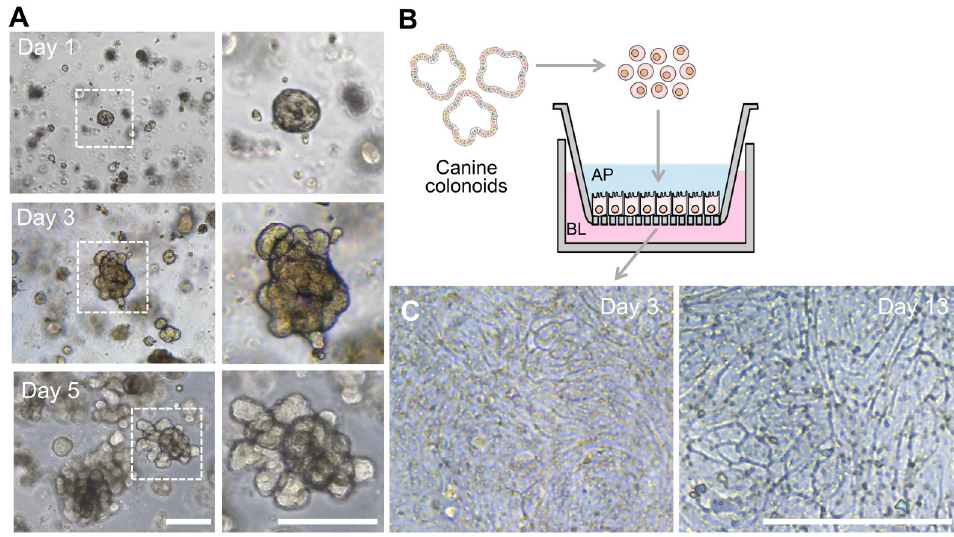
Fig 1. Morphological analysis of the 3D colonoids and the 2D canine colonic monolayer. ( A ) A growth profile of the colonoid isolated from the canine colonic crypt. A small spherical colonoids progressively grows to form fully grown colonoids. Representative phase-contrast micrographs were taken at days 1, 3, and 5. The zoomed-in inset at each day shows the high-power magnification of a colonoid in the white dashed box. ( B ) A schematic displays the procedure of the formation of an epithelial monolayer derived from 3D canine colonoids. The fully-grown organoids are dissociated into single cells, then seeded into a nanoporous insert to form a monolayer. AP, apical; BL, basolateral. ( C ) Representative phase-contrast micrographs on day 3 and 13 are provided, respectively. Bars, 200 μ